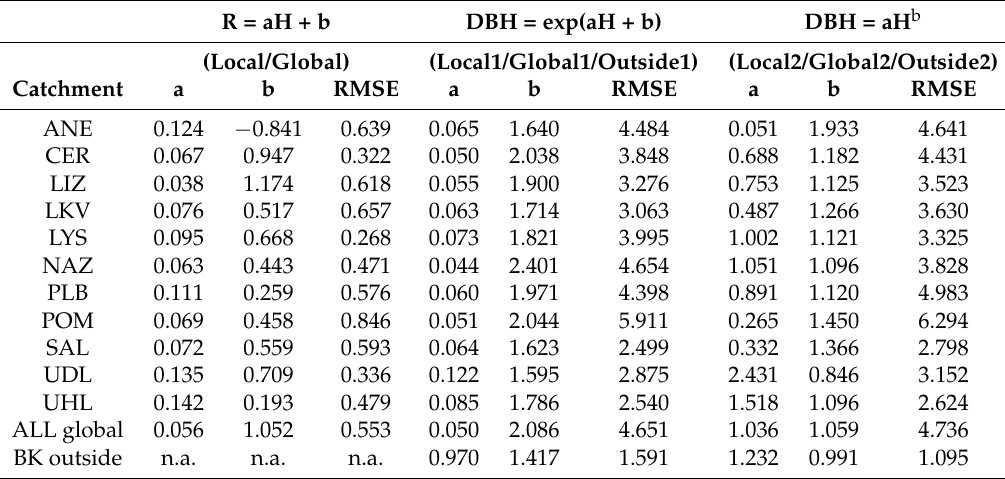
Table 4. Allometric equations for estimating tree crown radius (R) and stem diameter at breast height (DBH) from the measured tree height (H) for Norway spruce. Local equations are computed for each catchment and the global equation is computed for all catchments together. In the last row, we also included the local model that was computed outside the GEOMON catchments for the Bílý Kˇríž study site. R = aH + b DBH = exp(aH + b) DBH = aH